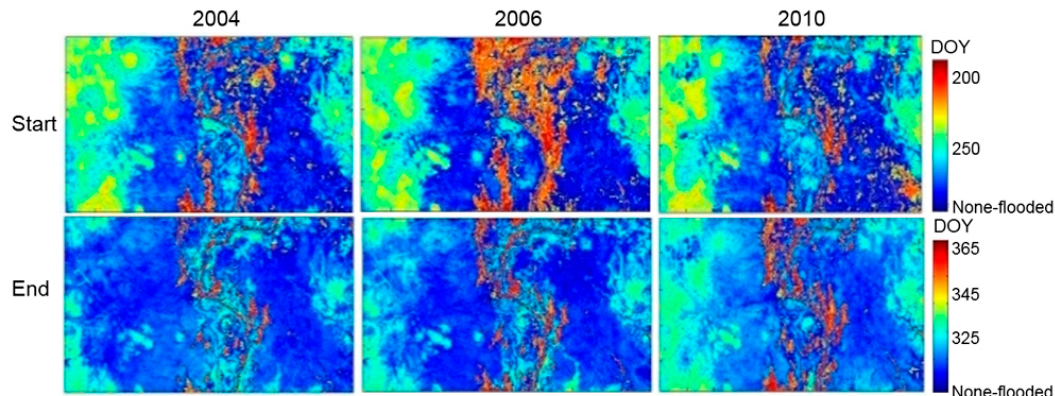
Figure 5. Spatial distribution maps of start/end dates (day of year (DOY)) of flooding in 2004, 2006 and 2010 using modified WFFI with MODIS data.